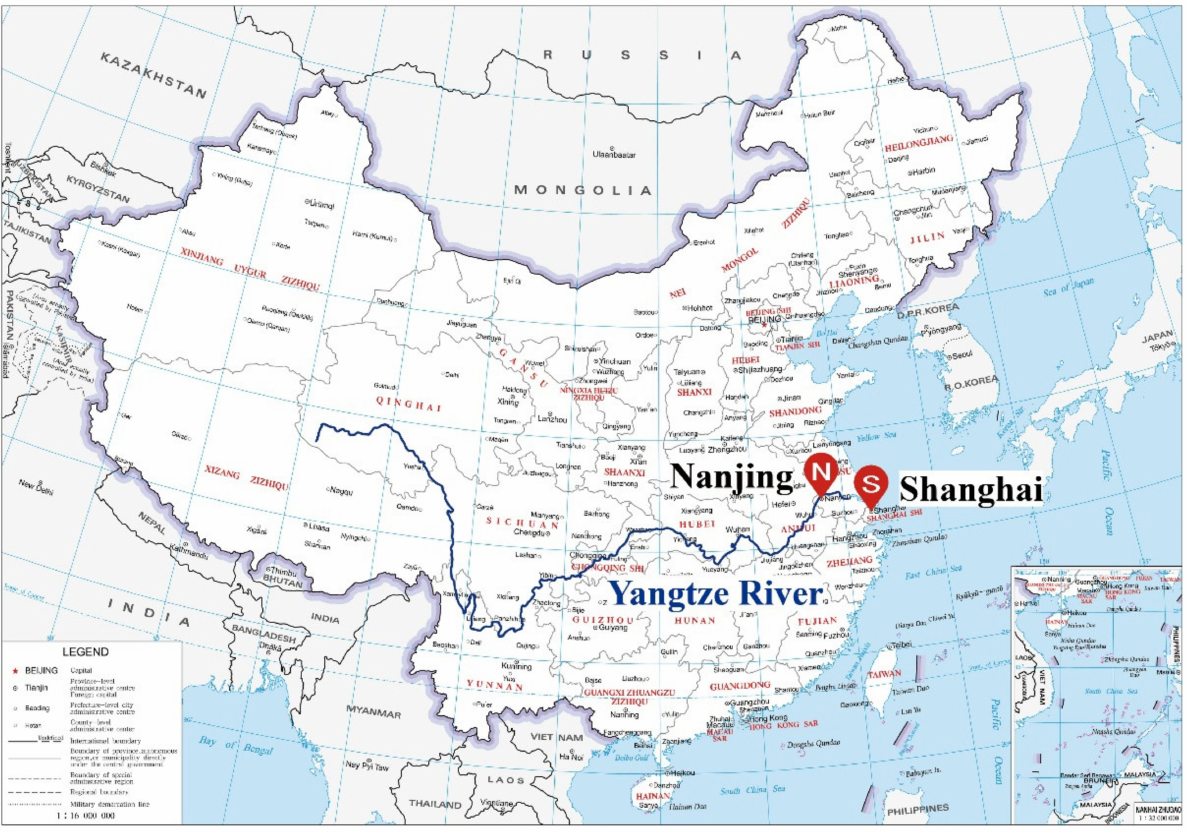
Figure 2. Location of